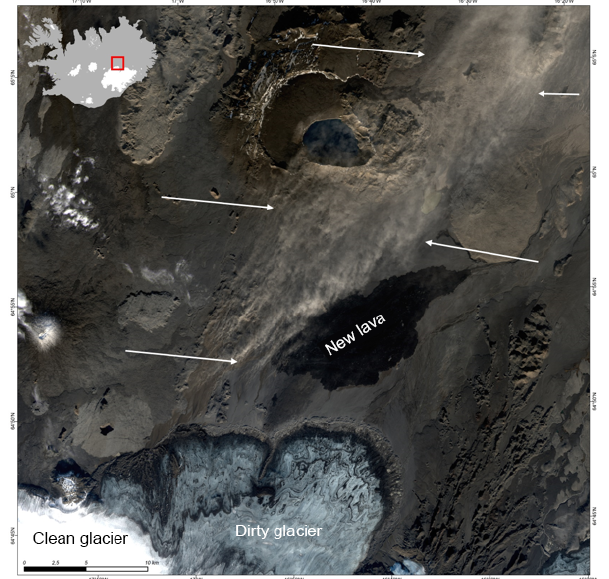
Figure 5. Landsat image of the Vatnajökull glacier (lower left cor- ner, clean and dirty) polluted with dust (lower middle, dirty glacier) with a dust storm (brown dust plume indicated with white ar- rows) originating from the glacial flood plain Dyngjusandur over the new lava (dark surface in the centre of the image) from the Holuhraun eruption 2014–2015. Data are from https://landsat.usgs. gov/landsat-data-access (last access: 4 February 2019).